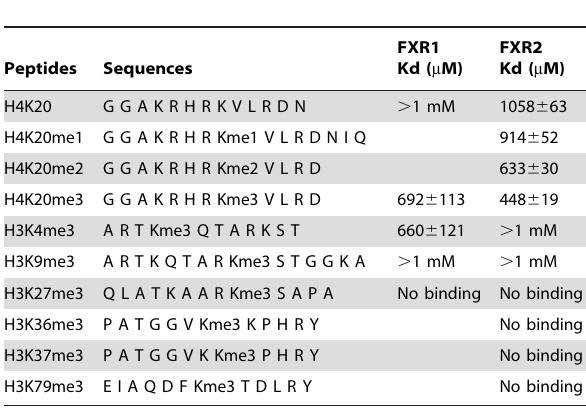
Table 2. Binding affinities of FXR1 or FXR2 Tudor domains to histone H3 or H4 methylated lysine